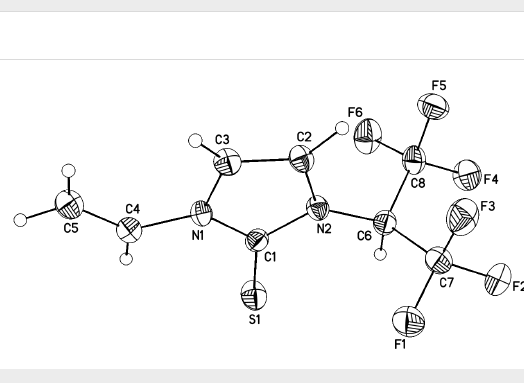
Figure 3: Crystal structure of 5 with thermal ellipsoids drawn at the 30% probability